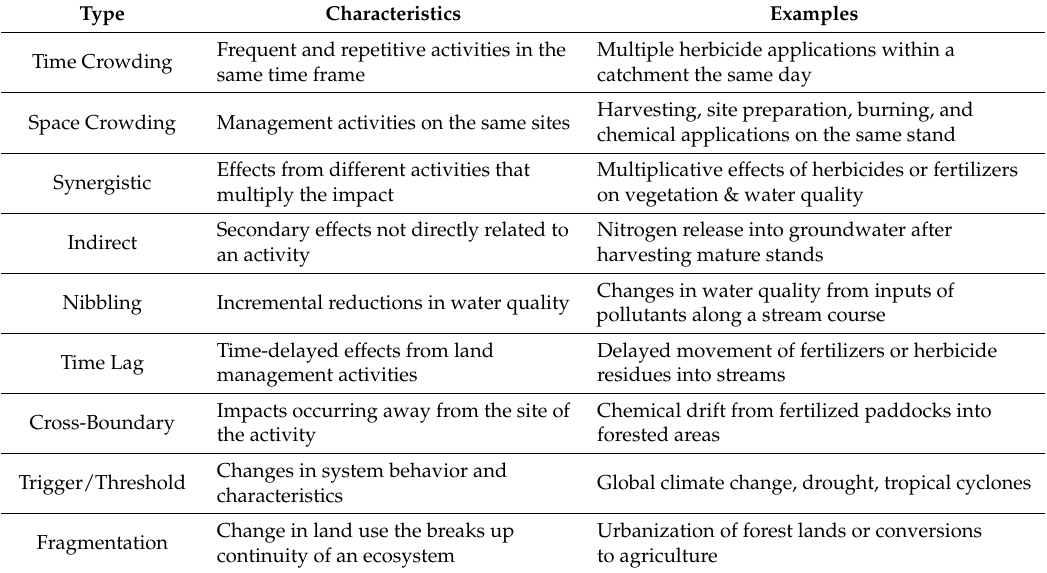
Table 1. Cumulative effects types, characteristics, and examples adapted from Spaling